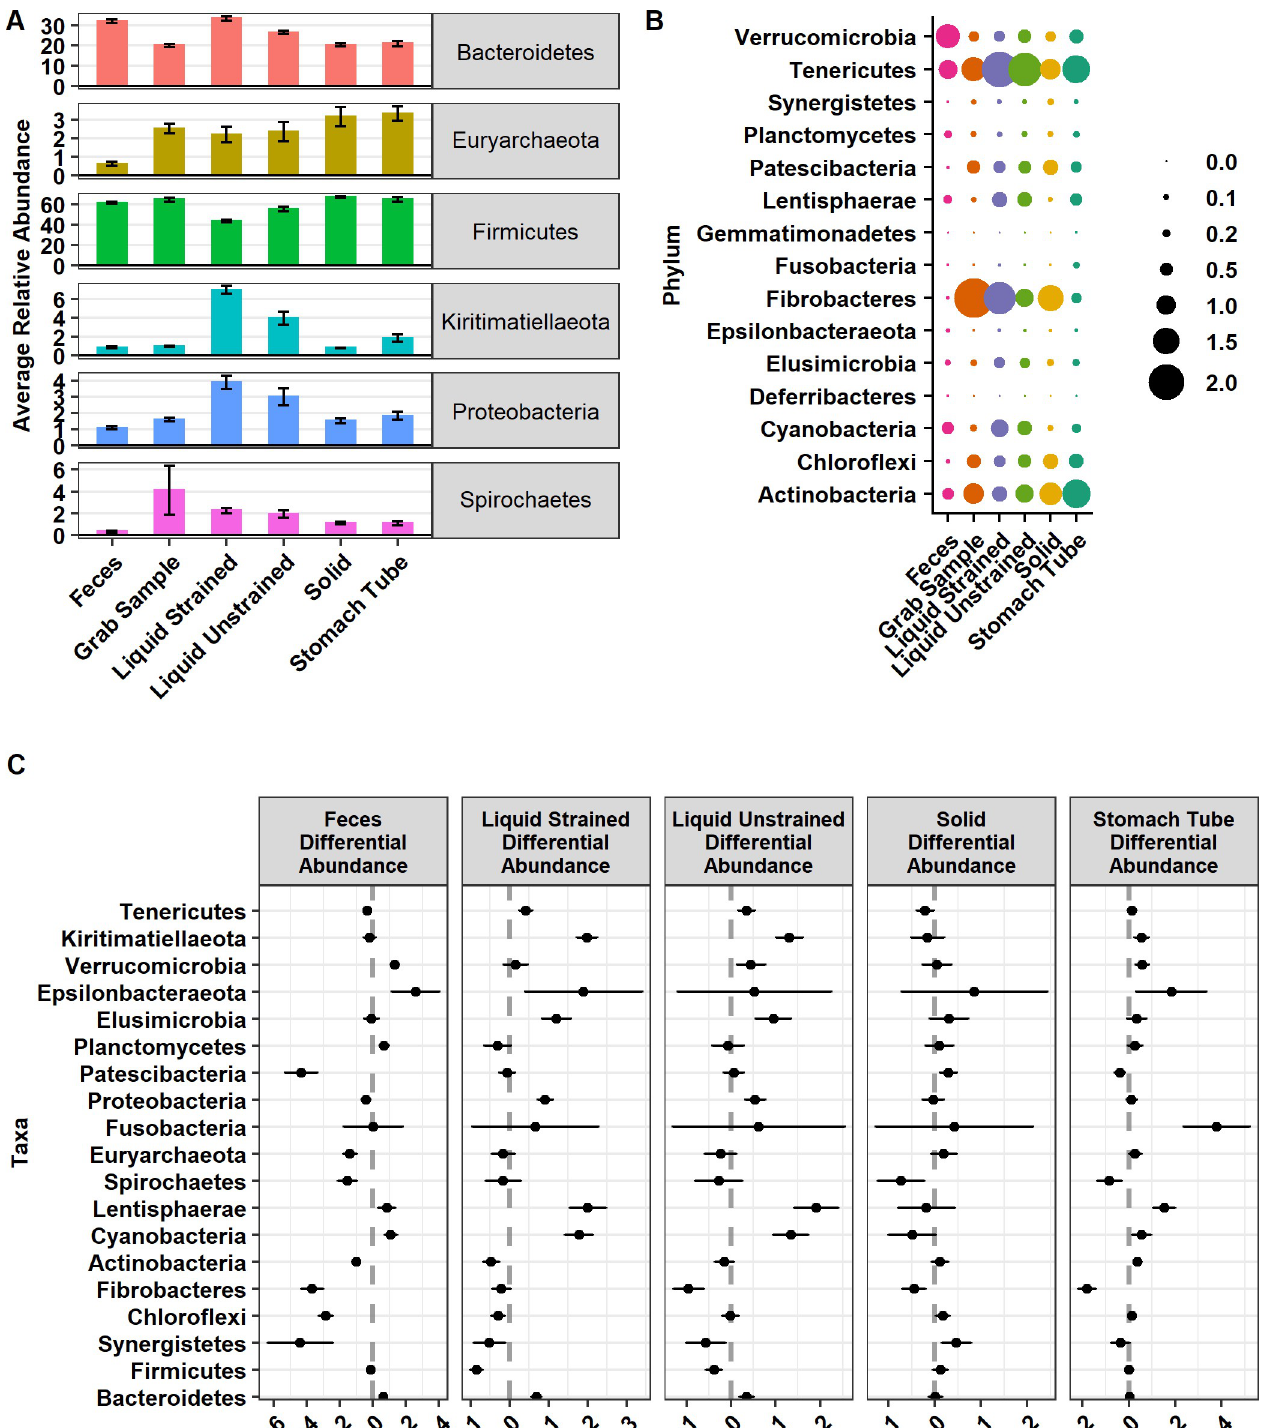
Fig 1. Relative abundance of (A) major and (B) minor phyla and (C) their differential abundances. (A) Relative abundance of major phyla defined as those phyla found at greater than 3% relative abundance and graphed as relative abundance ± SE. (B) Minor phyla defined as those found below 3% relative abundance present in sample types. (C) Phyla that are significantly differentially abundant compared with grab samples. Graphed as coefficients with a 95% confidence interval from the corncob model. Families with negative coefficients for a sample type are expected to have a lower relative abundance when compared to the grab samples while positive coefficients suggest a higher relative abundance in that sample type compared to grab samples.